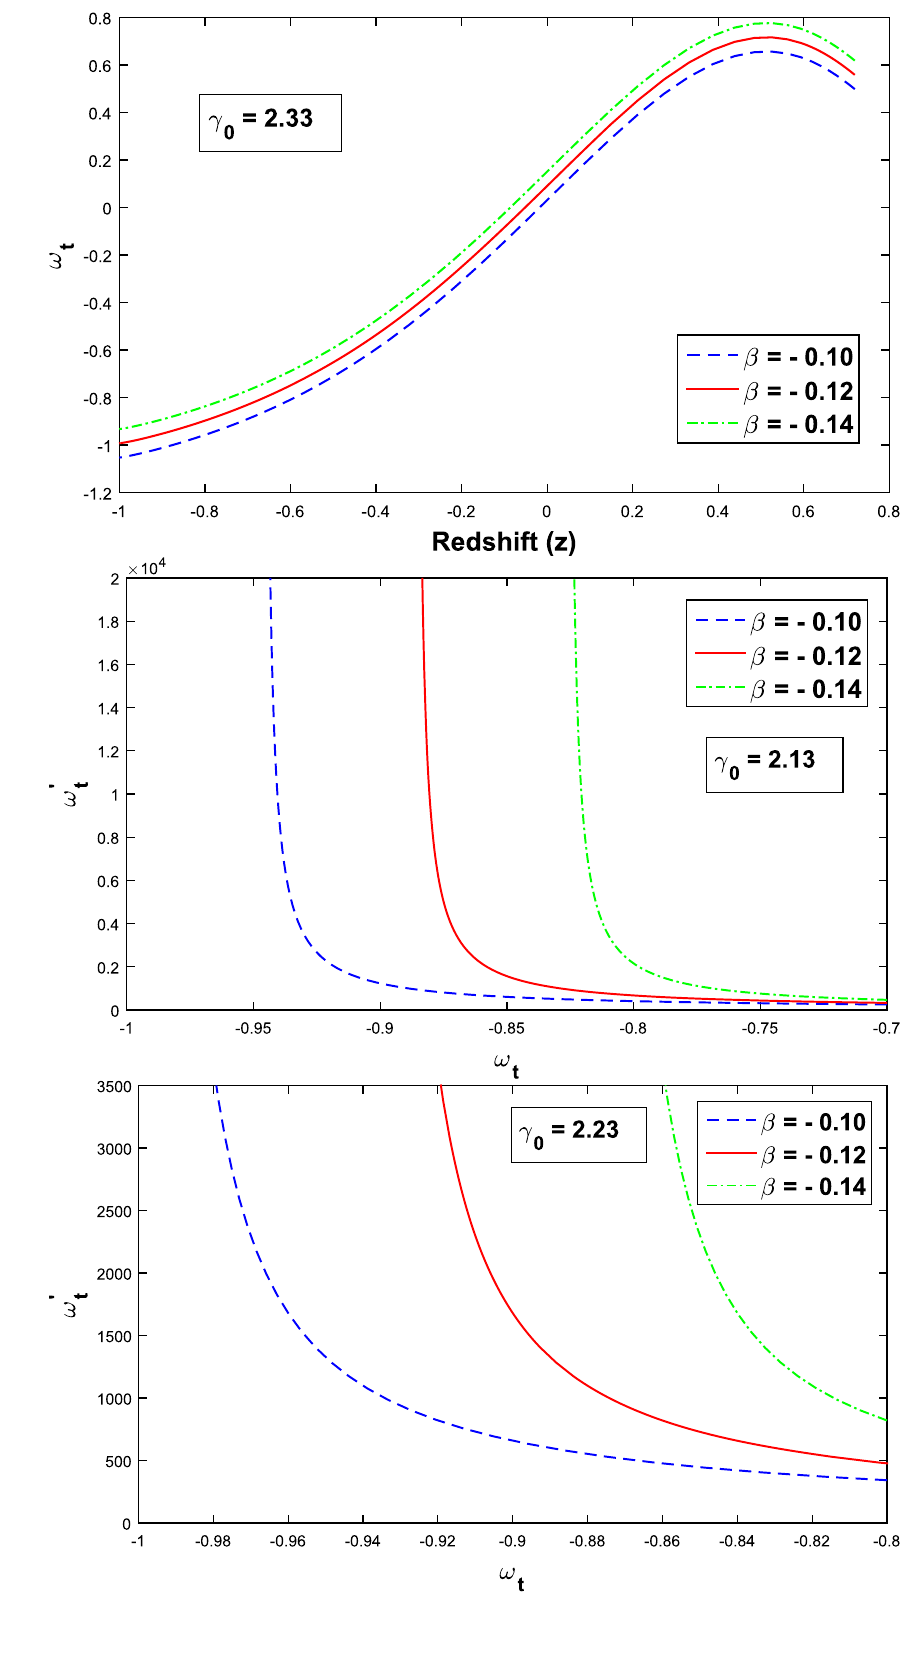
Fig. 9 Plot of EoS parameter of THDE versus redshift ( z ) for c 1 = 0 . 01, c 2 = 0 . 115, k = 0 . 325, γ 0 = 2 . 33, β = − 0 . 10 , − 0 . 12 , − 0 . 14, and α = 1 . 5